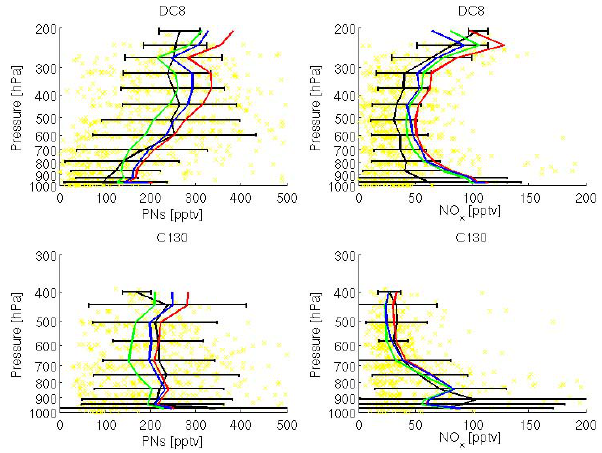
Fig. 7. Campaign average vertical profiles of peroxyacyl nitrates and nitrogen oxides for the C-130 and DC-8 aircraft. NO x from both platforms was obtained from the chemiluminescence instru- ments. PANs on the C-130 were measured with PAN-CIGAR, and PANs on the DC-8 by the TD-LIF instrument. Aircraft data are plotted as yellow crosses, with black lines to represent the mean and standard deviation of the measurements at each of the model vertical levels. Red lines represent campaign average profiles from the baseline simulation; green, from the “no Asia” simulation; and, blue, from the “no lightning” simulation. Simulations are sampled along the aircraft flight tracks.